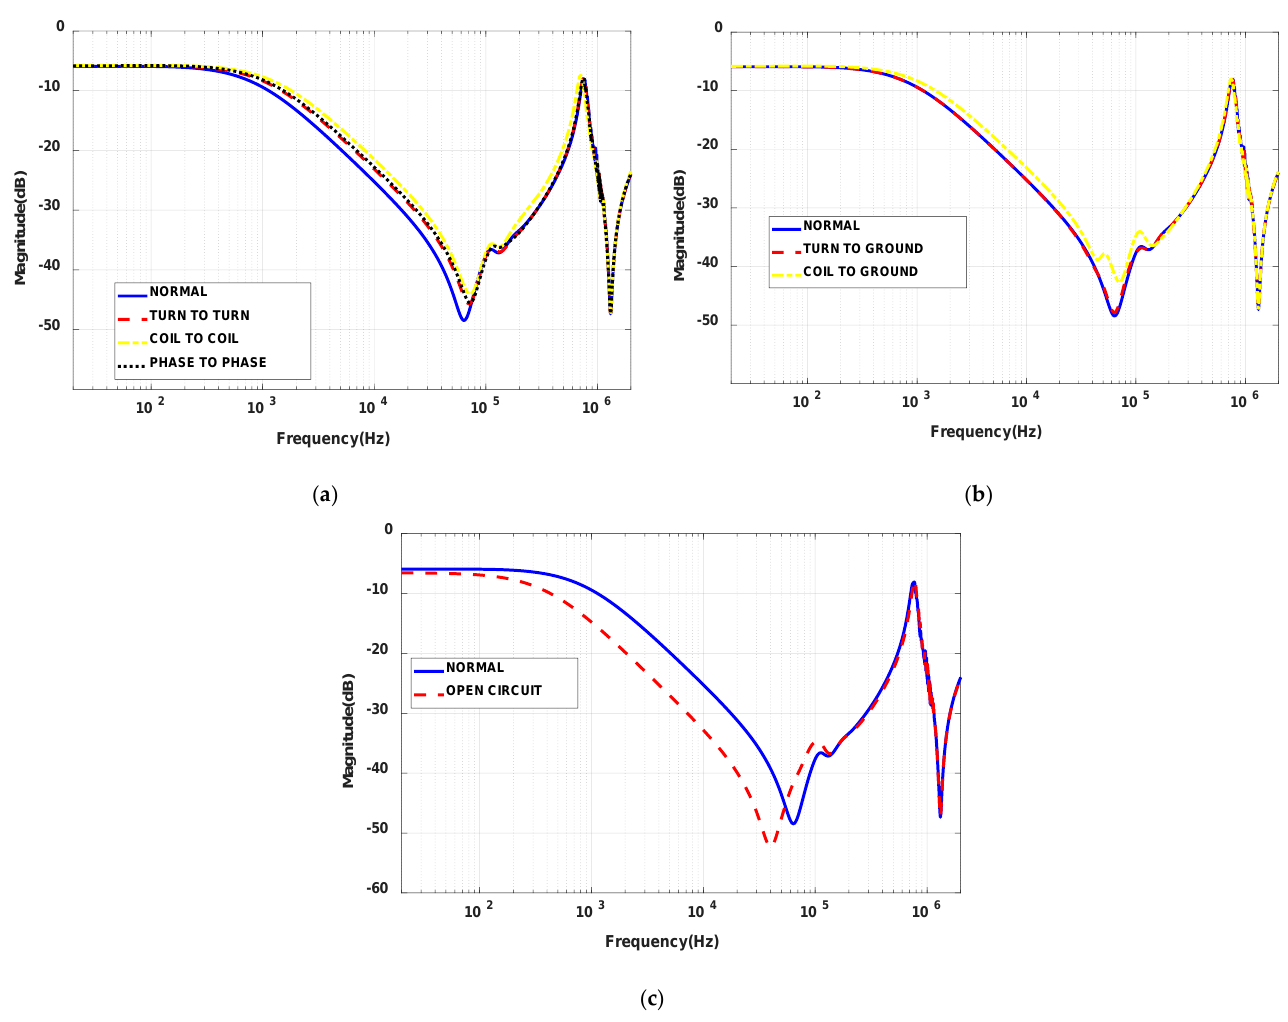
Figure 9. U–V FRA measured responses for the tested IM with stator delta connection for ( a ) Normal vs turn − to − turn, coil − to − coil, and phase − to − phase SC faults and ( b ) Normal vs turn − to − ground, and coil − to − ground SC faults, ( c ) Normal vs. OC fault.